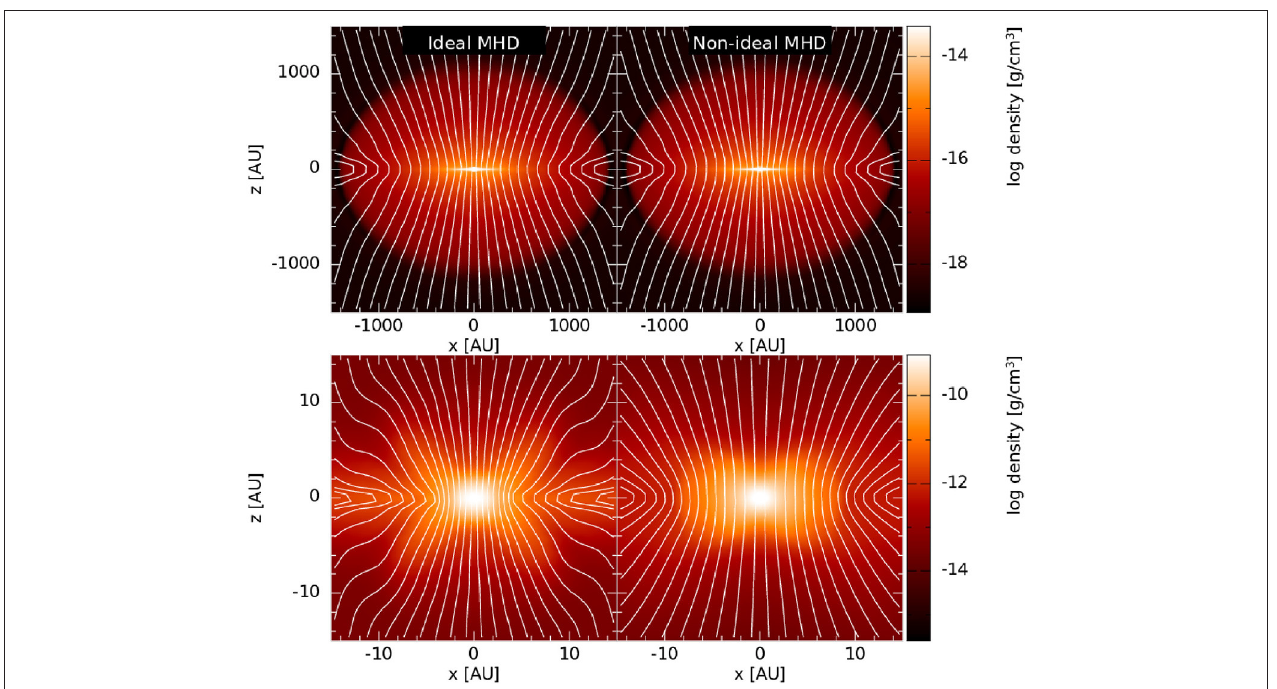
FIGURE 2 | The magnetic field lines superimposed on a density slice during the first hydrostatic core phase for ideal and non-ideal MHD simulations. The initial mass-to-flux ratio is five times the critical value (i.e., µ 0 = 5). In ideal MHD, the magnetic field lines are dragged inwards as the cloud core collapses, creating the characteristic hour-glass shape. On the large scale, the non-ideal effects have minimal effect on the strength and structure of the magnetic field, whereas on the small scale, the neutral particles flow through the magnetic field lines to form the first hydrostatic core, while preventing the magnetic field lines from becoming pinched and preventing a strong magnetic field from building up in the core (bottom). These images are inspired by Figure 2 of Price and Bate (2007) and Figure 1 of Bate et al. (2014)